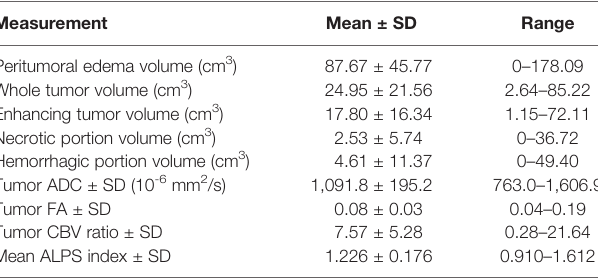
TABLE 2 | Results of volume, ADC, FA, CBV, and ALPS index